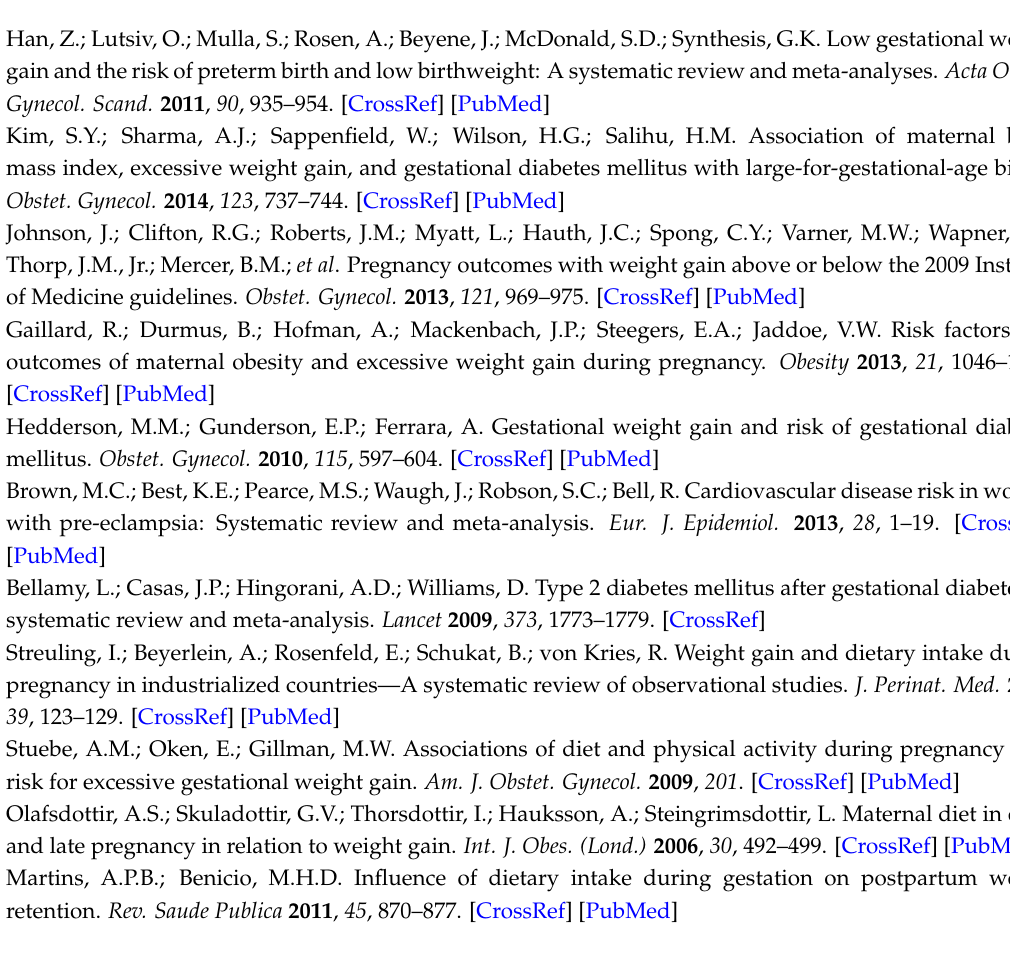
with 95% CI. Panel B zooms in on the effect estimates, Table S1: Food groups and its food components, Table S2: Modified version of the Dutch Healthy Diet-index, Table S3: Sensitivity analyses in normal weight women ( n = 2141), Table S4: Sensitivity analyses in overweight women ( n = 674), Table S5: Gestational weight trajectories in normal weight and overweight women ( n = 3374), Table S6: Association of dietary patterns with adequacy of weekly gestational weight gain ( n =